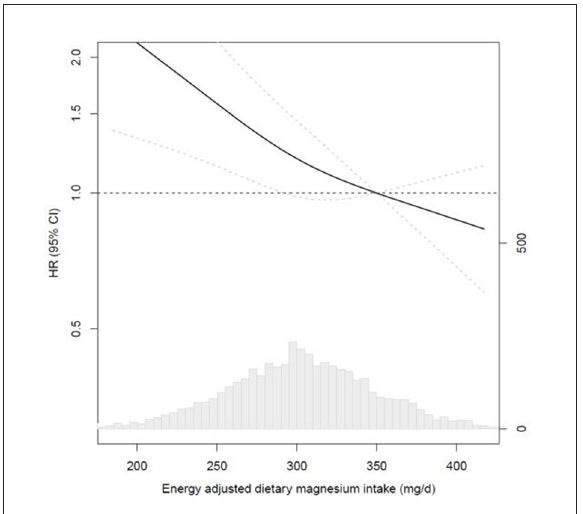
FIGURE1 Multivariable-adjusted restricted cubic spline analyses for the continuous association of energy-adjusted magnesium intake with CVD mortality in 4,365 post-MI patients from the Alpha Omega Cohort. HRs for CVD mortality (left y-axis) are presented as a bold line for every level of magnesium intake; the reference (HR of 1.0) was set at 350 mg/d, which is the Adequate Intake for men; HRs were fully adjusted (see Table 3, model 4); knots were placed at the 10th, 50th, and 90th percentile; dotted lines indicate 95% Cis; the bottom graph shows the distribution of magnesium intakes in the Alpha Omega Cohort, with frequencies on the right y-axis. CVD, cardiovascular disease; MI, myocardial